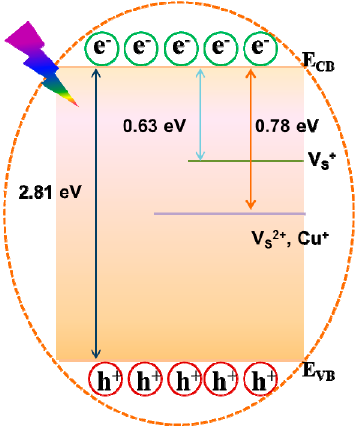
Figure 8. Energy-level diagram of Cu+ adsorbed on the surface of CA-CdS QDs.